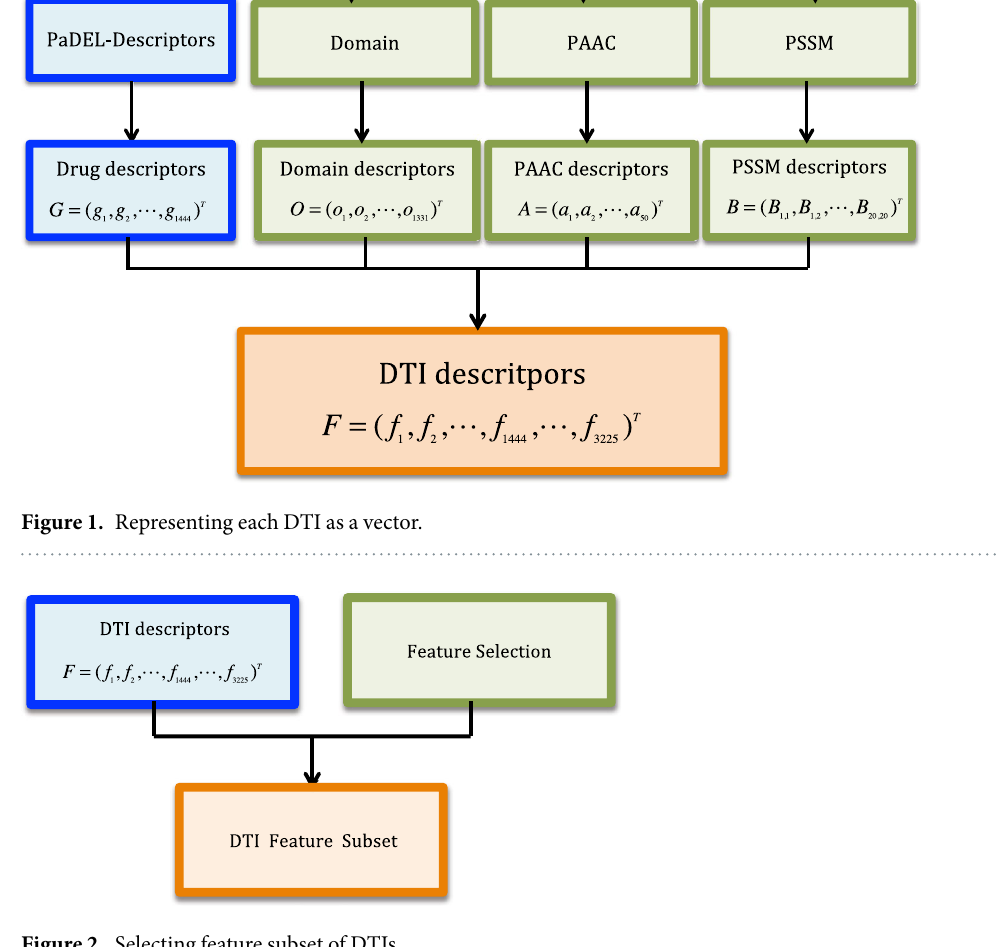
Figure 2. Selecting feature subset of